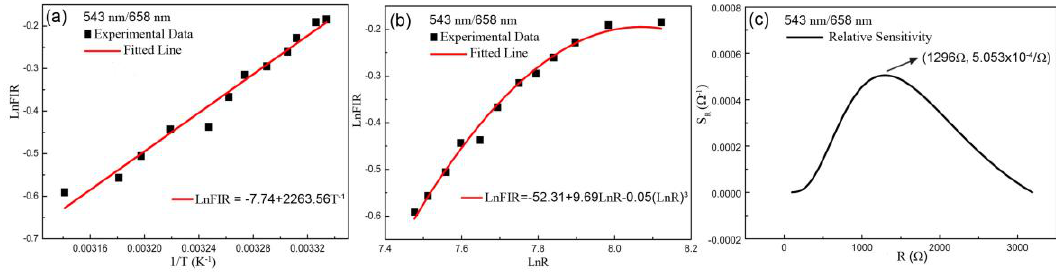
Figure 7. Sensitivity characterization of the sensor. ( a ) Dependence of relative sensitivity S R on the number of cycles. ( b ) The fitted and experimental data points showing the dependence of the resistance on temperature. ( c ) Dependence of the resistance error δ R on temperature.